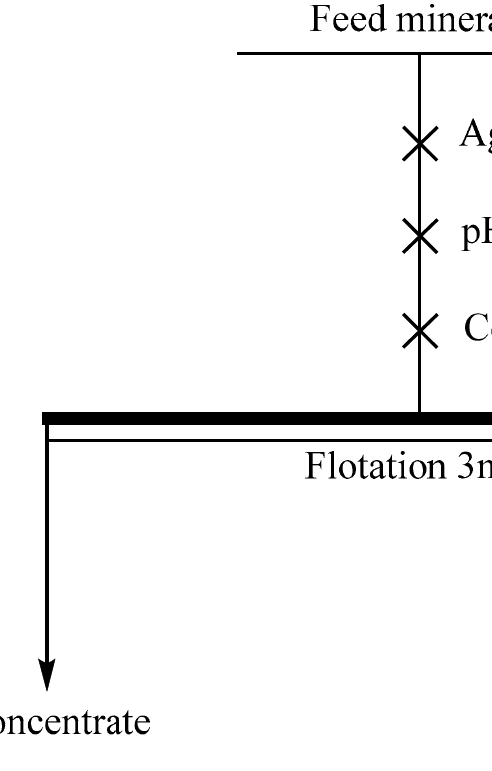
Figure 2. Flowsheet of pure mineral flotation test.